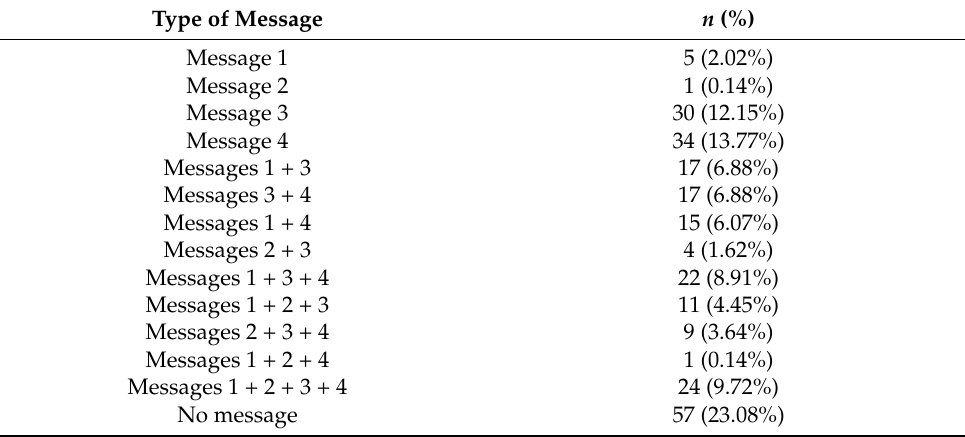
Table 5. Analysis of the appropriateness of the included infographics according to the presence of key messages aimed at helping the population to better understand the use of antibiotics. Type of